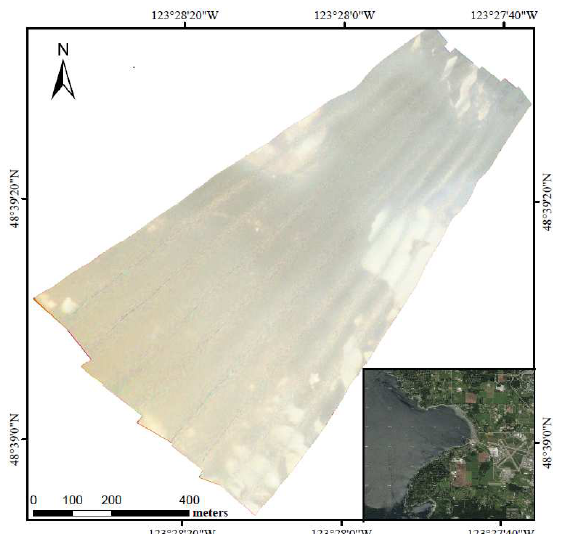
Figure 3. Patricia Bay 2016 Dataset. A pseudocolor is presented from the combination of 100 kHz, 200 kHz and 400 kHz backscatter